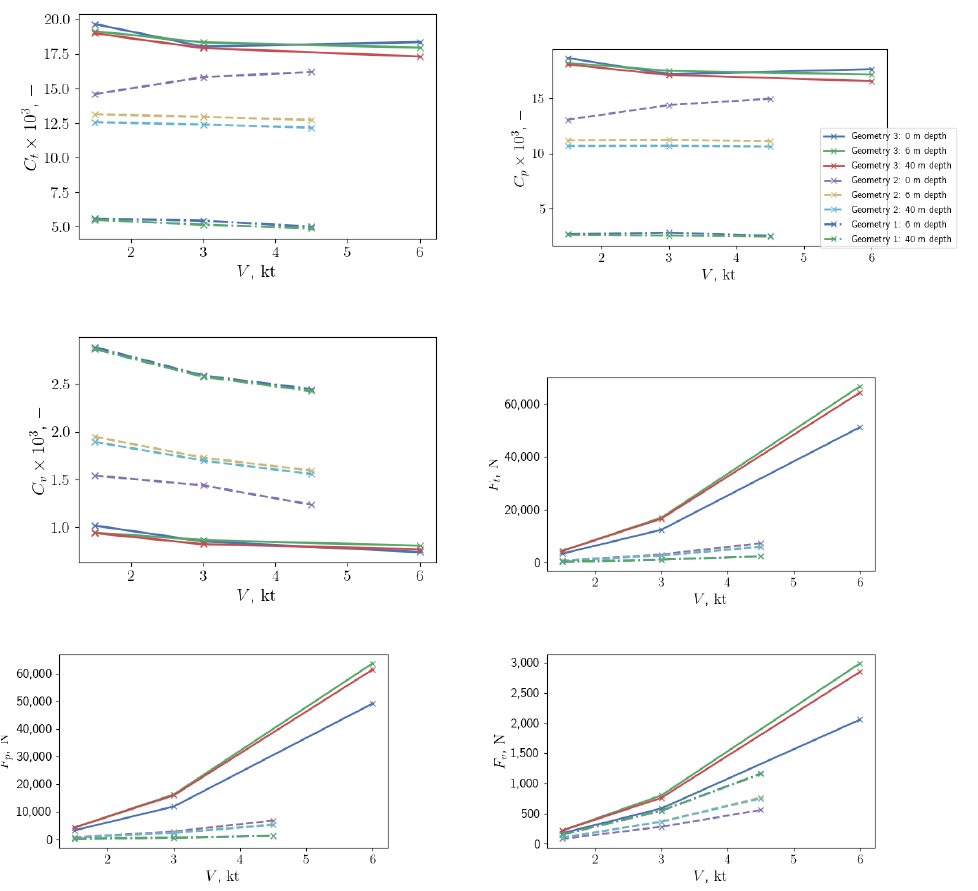
Figure 8. Total resistance results for all